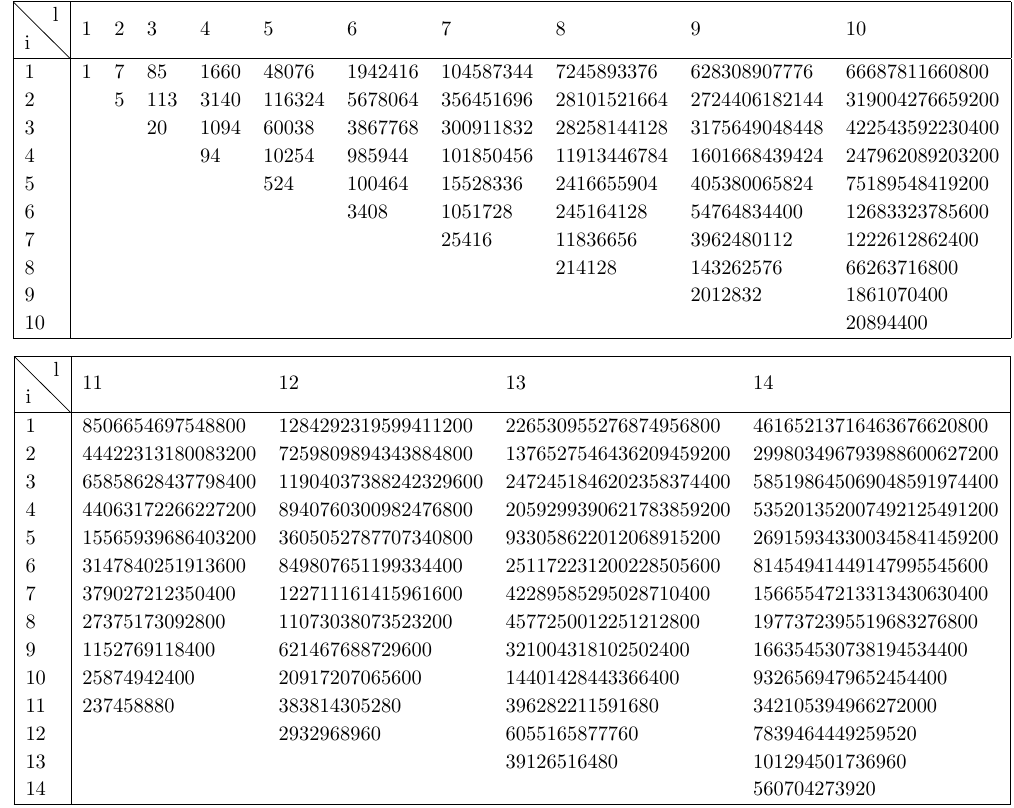
of (4.4), with i running vertically and l i